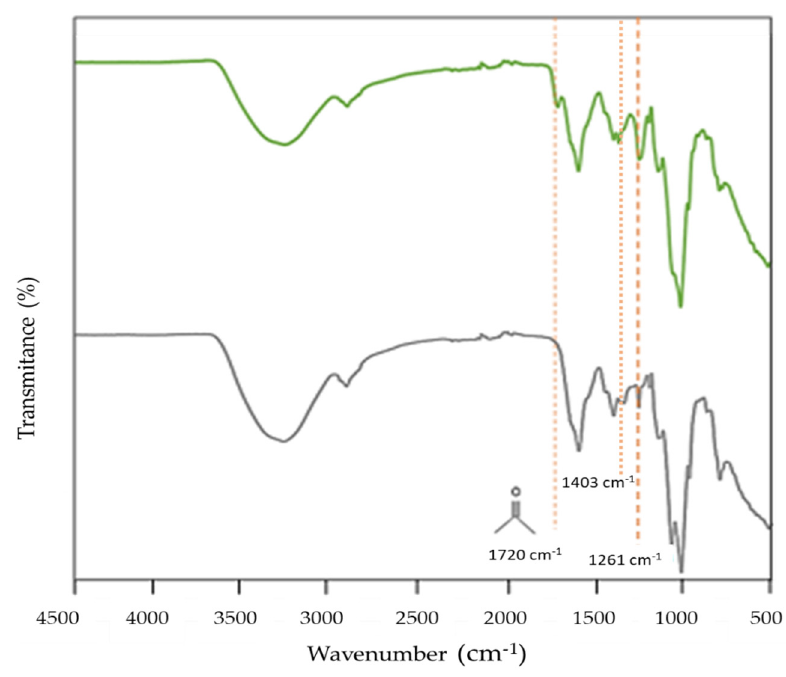
Figure 1. FT − IR spectra of FucoPol (green line) and d-FucoPol (grey line).